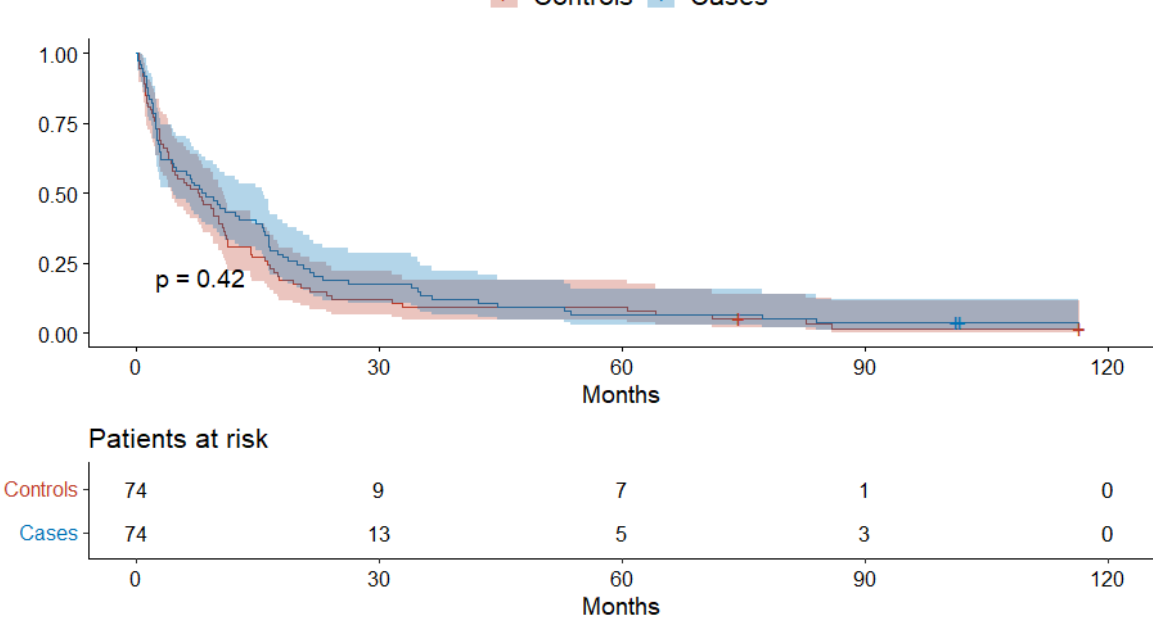
Figure 4. The overall survival of cases and controls with one or two comorbidities. Figure 5. The overall survival of cases and controls with three or more comorbidities.